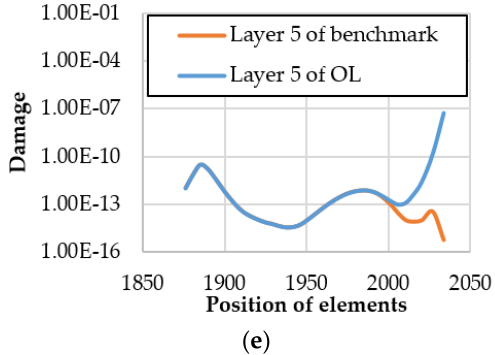
Figure 22. Comparison of the benchmark and OL models on each layer: ( a ) Comparison of the results of layer 1 in each model; ( b ) Comparison of the results of layer 2 in each model; ( c ) Comparison of the results of layer 3 in each model; ( d ) Comparison of the results of layer 4 in each model; ( e ) Comparison of the results of layer 5 in each model;